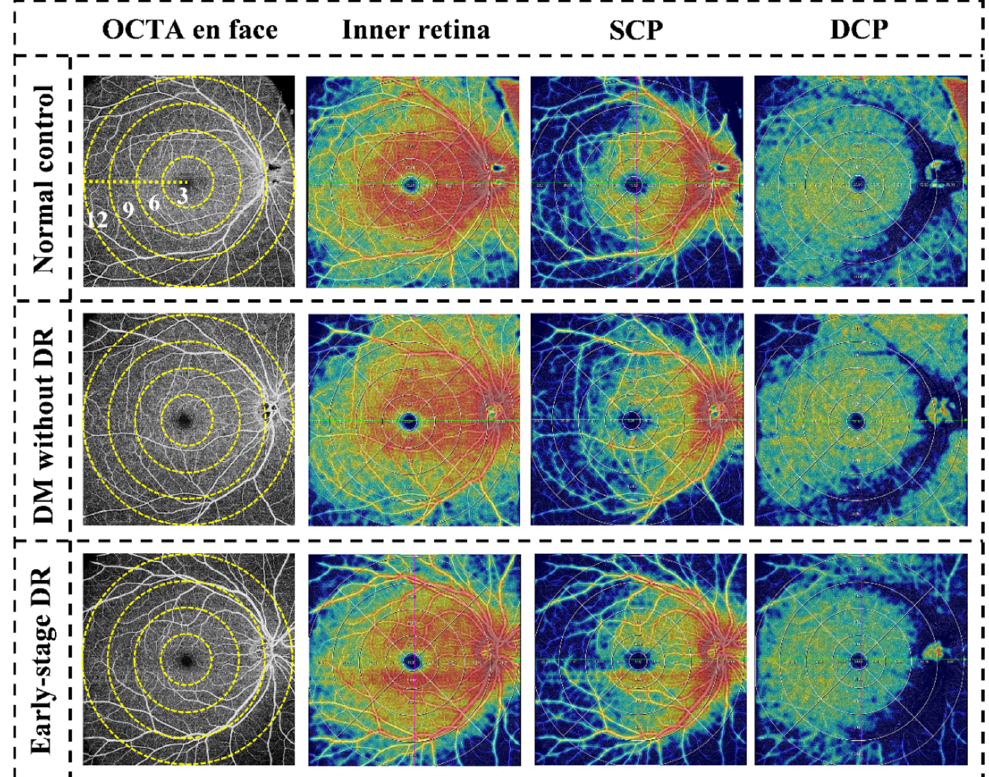
Figure 2. Examples of quantitative measurement using Wide-field OCTA. The left column represents en face images (12 × 12 mm) of color code for vessel density. The following columns represent en face images of the corresponding layer of the inner retina, SCP, and DCP of color code for perfusion. The vessel density of the inner retina, SCP, and DCP were separately calculated in the whole area (diameter of 12 mm) and concentric rings with different radii (0–3, 3–6, 6–9, and 9–12 mm). OCTA, optical coherence tomographic angiography; SCP, superficial capillary plexus; DCP, deep capillary